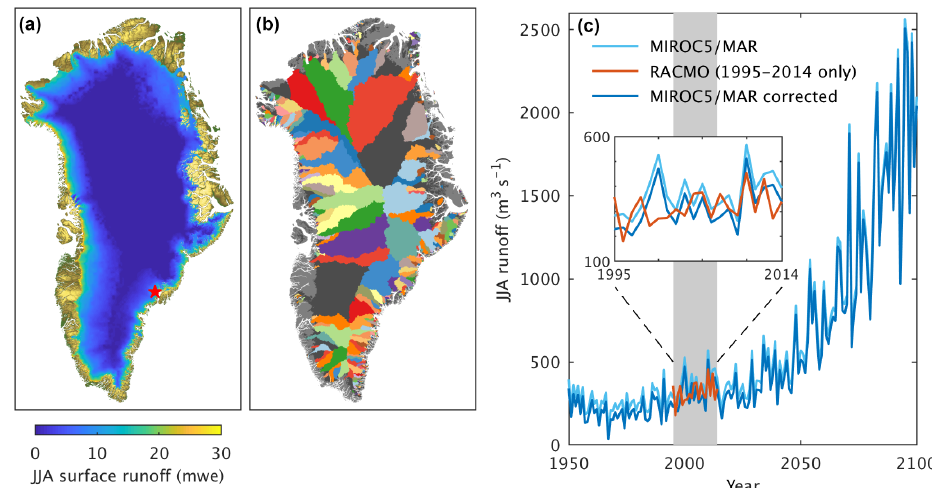
Figure 2. Illustration of atmospheric processing for the MIROC5 RCP8.5 scenario. (a) Simulated June–July–August (JJA) surface runoff in 2100 in the regional climate model MAR3.9.6 forced at its boundaries by MIROC5. (b) Tidewater glacier drainage basins delineated based on the hydropotential defined in Eq. (3). (c) JJA runoff time series for Helheim Glacier in SE Greenland (location shown as red star in a ). The vertical grey shading shows the 1995–2014 present-day time period used for the bias correction. The raw MAR output is in light blue, RACMO during the present-day period is in red and the bias-corrected MAR output is in dark blue. The inset shows the present-day time